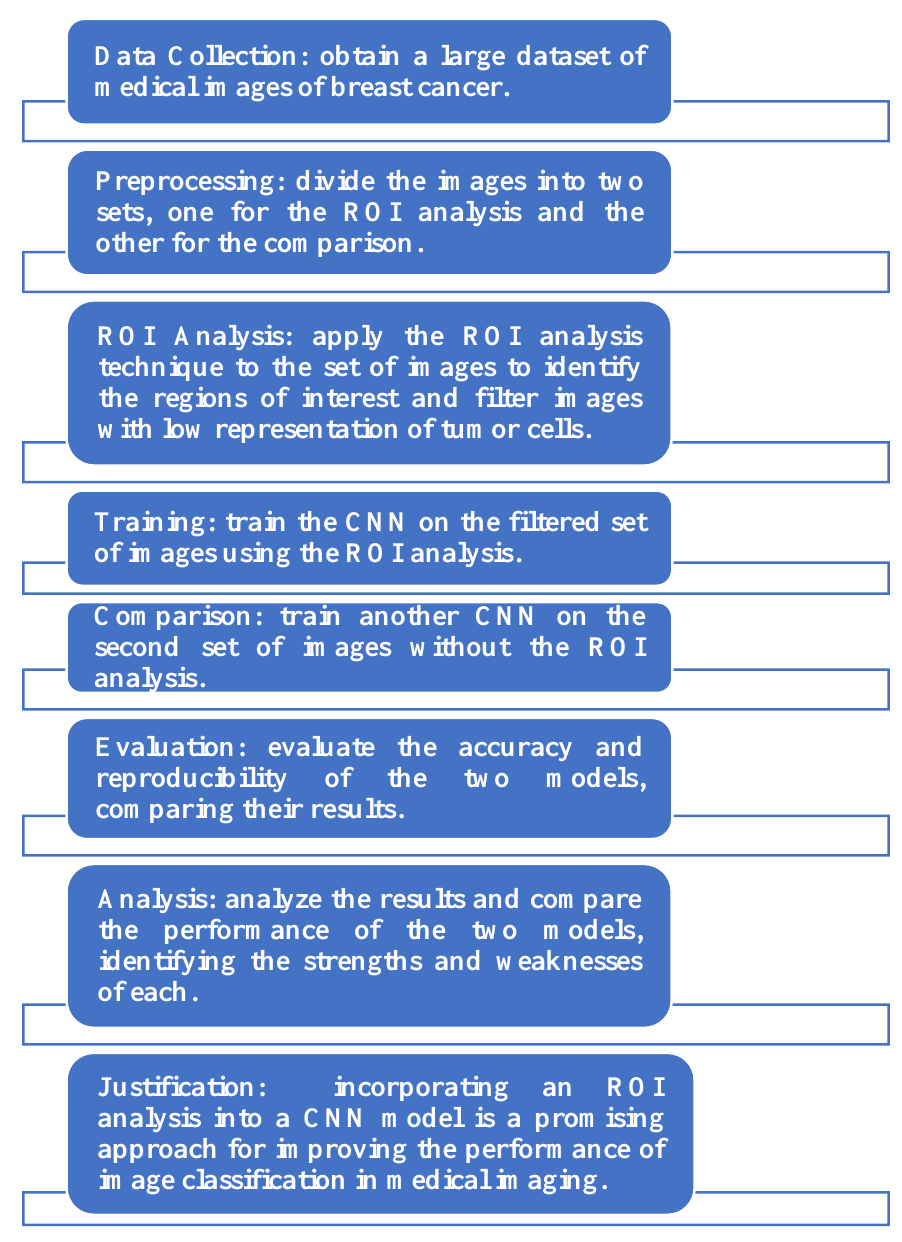
Figure 6. The CNN model with ROI and without ROI .